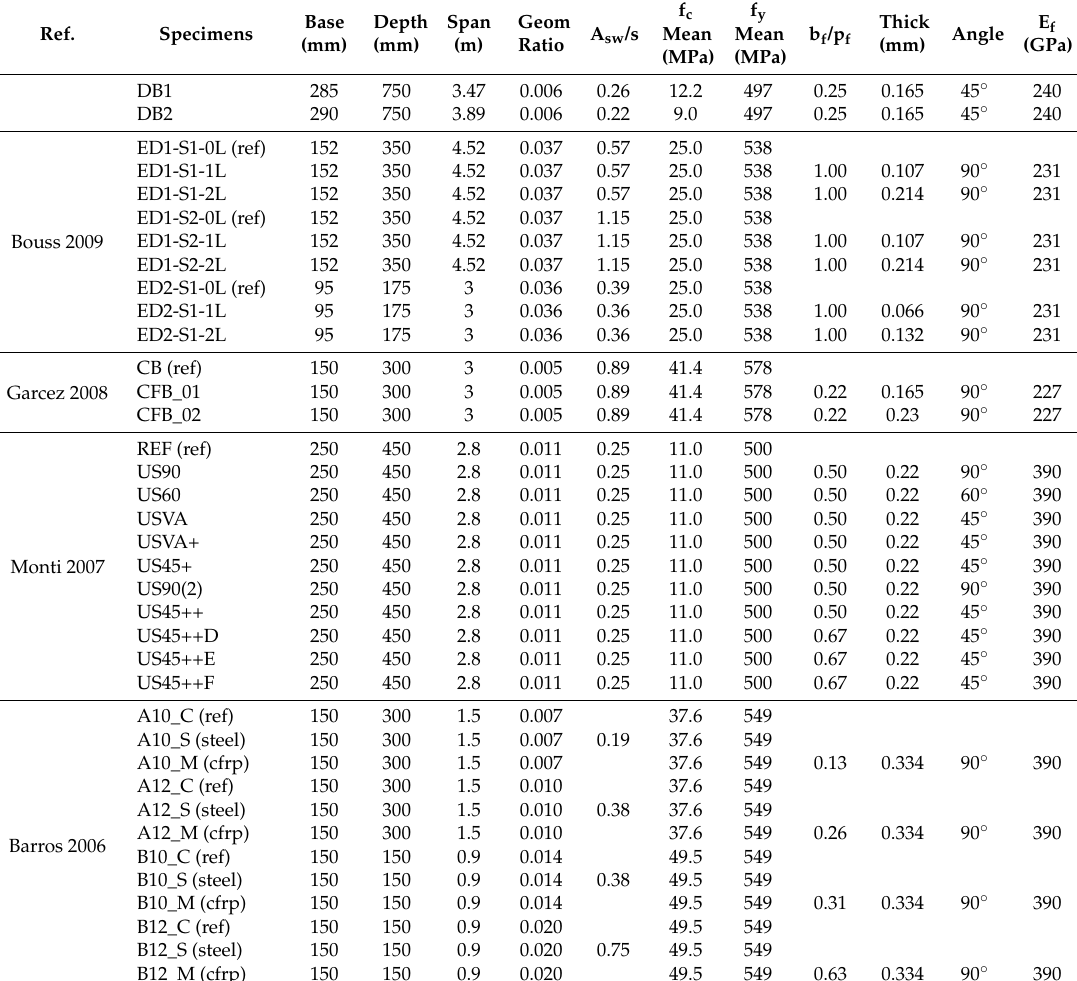
Table A1. Geometrical and mechanical properties of the selected RC beams and FRP strengthening; the “ref” beams are the ones without FRP retrofitting [38,39,54,72–77].